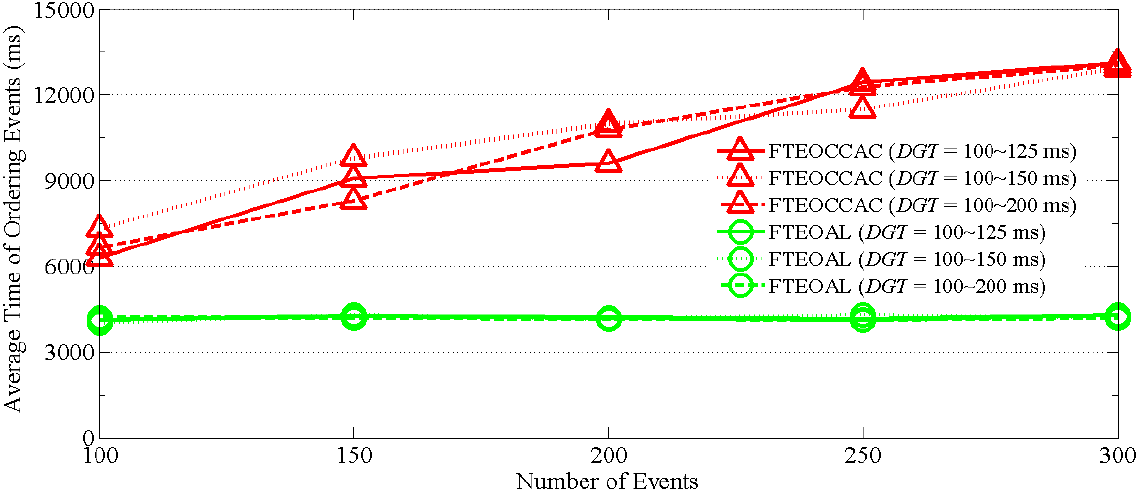
Figure 11. AT in FTEOCCAC and OBDC for different DTG ( P d = 0-30%, DT = 2000 ms, P l =